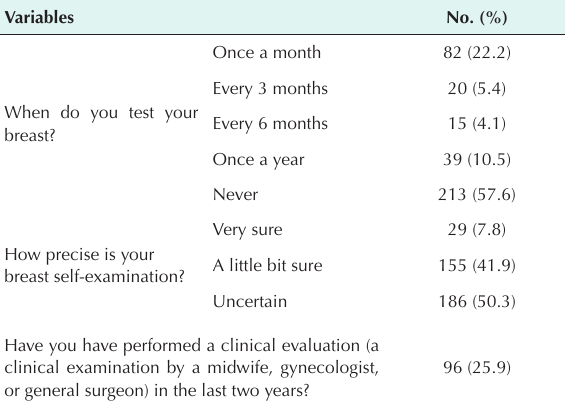
Table 3. Frequency and Percentage of Responding Samples to Performance Questions Variables No.